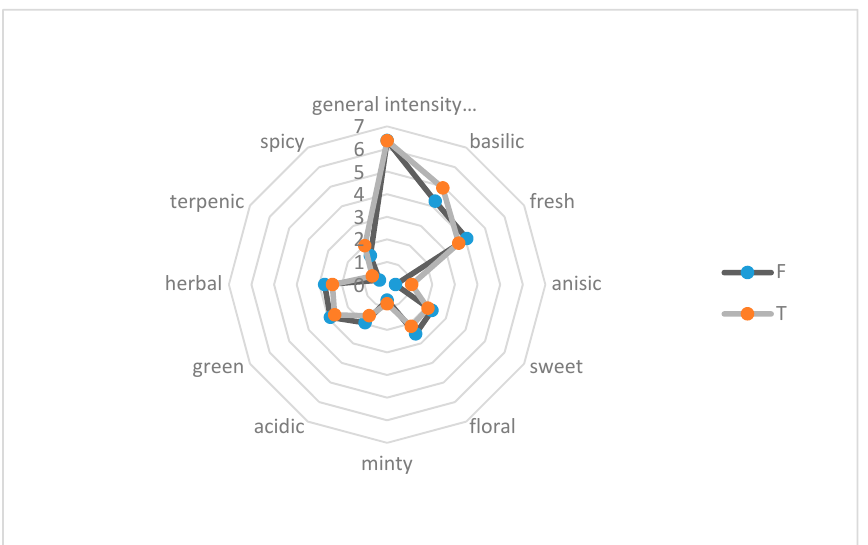
Figure 1. Diagram of sensory profile of fresh herb odor.